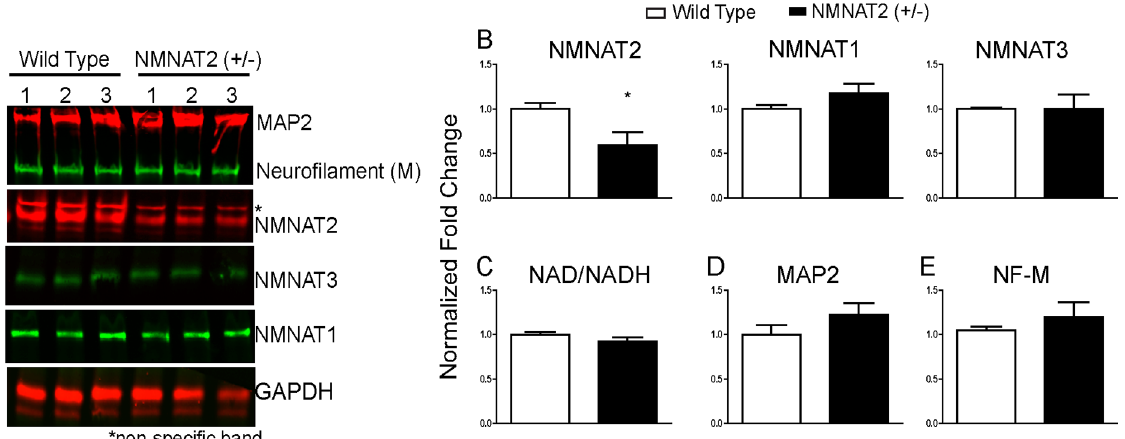
Fig 2. Dorsal root ganglia (DRG) derived from adult NMNAT2+/- mice do not display compensatory changes in other NMNAT levels, nor do they exhibit deficiencies in NAD/NADH activity or reductions in MAP2 or neurofilament levels compared to WT. A,B) DRG isolated from NMNAT2 +/- animals display a reduction in NMNAT2 levels but no changes in NMNAT1 or NMNAT3 levels. C) Average NAD/NADH activity levels do not differ in DRGs isolated from WT or NMNAT2+/- mice (shown as normalized NAD/NADH levels). D) microtubule associated protein 2 (MAP2) and neurofilament (NF-M) protein levels did not differ in NMNAT2+/- and WT mice ( * p < 0.05, ** p < 0.001, *** p <